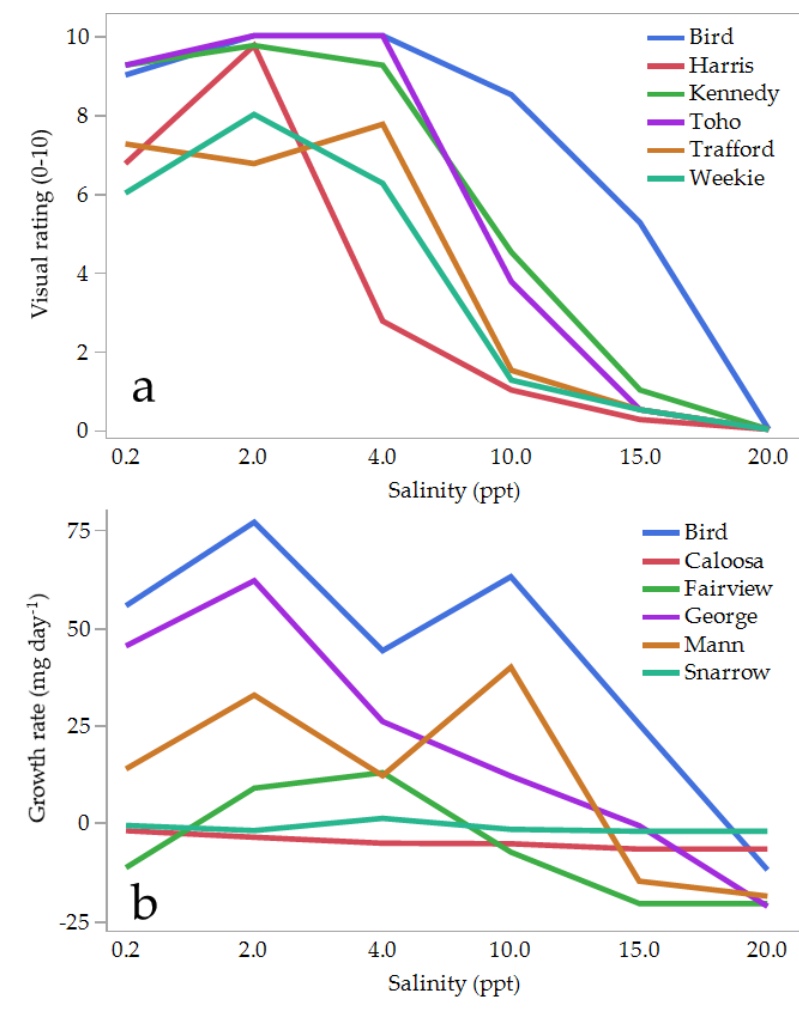
Figure 3. Visual rating and growth rate for subsets of the 24 Vallisneria americana ecotypes along the salinity gradient. Shown are three ecotypes with the highest and lowest ( a ) visual rating and ( b ) growth rates. Each line represents 30 observations.